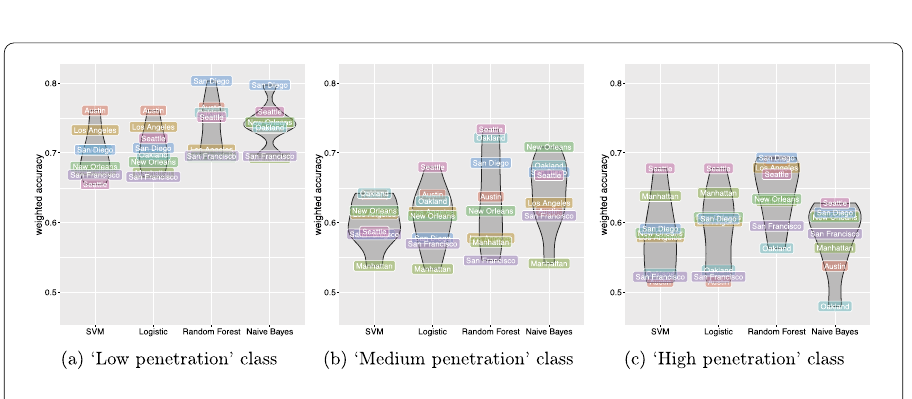
Figure 6 Weighted accuracy of our